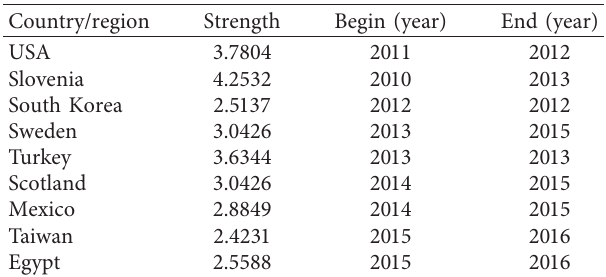
Table 2: Top nine countries/regions with the strongest citation bursts.